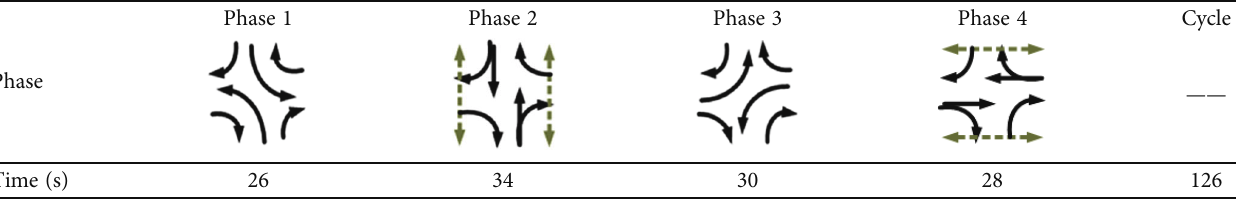
Table 1: Intersection signal timing scheme.